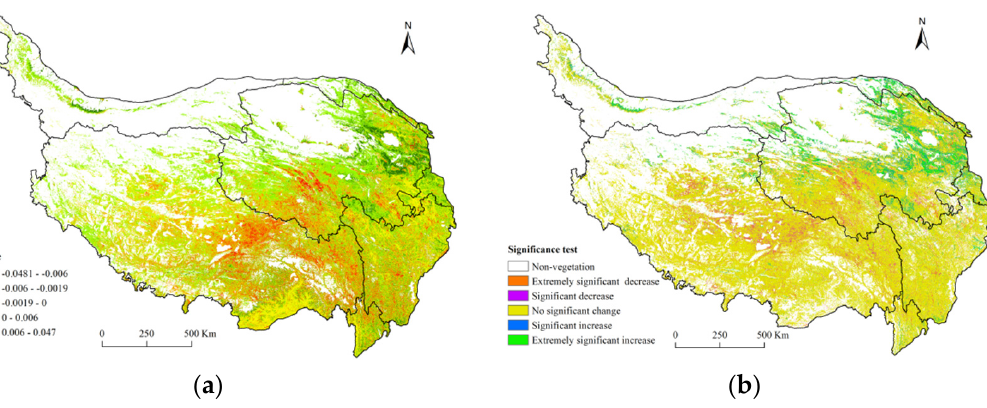
Figure 4. Spatial ( a ) change rate and ( b ) significance test of FVC on the Qinghai–Tibet Plateau. For different soil types, the mean trend values of spatial change rate (Figure 4a) for seasonal frozen soil, permafrost soil, and unfrozen soil regions were 0.0002, 0.0004, and 0.001, respectively, indicating that the FVC in different soil type regions showed gradual increasing trends and the mean trend of unfrozen soil was relatively higher than those of permafrost and seasonal frozen soil. In terms of vegetation growth trends, seasonal frozen soil exhibited a trend of gradual decline in 52.48% of the total area, distributed mainly in southeastern and southern Xinjiang Province, northern Tibet, and central and western Qinghai Province. The area with a trend of gradual rise accounted for 47.52% of the